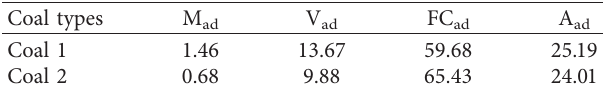
Table 1: Proximate analysis of coal samples from different coal